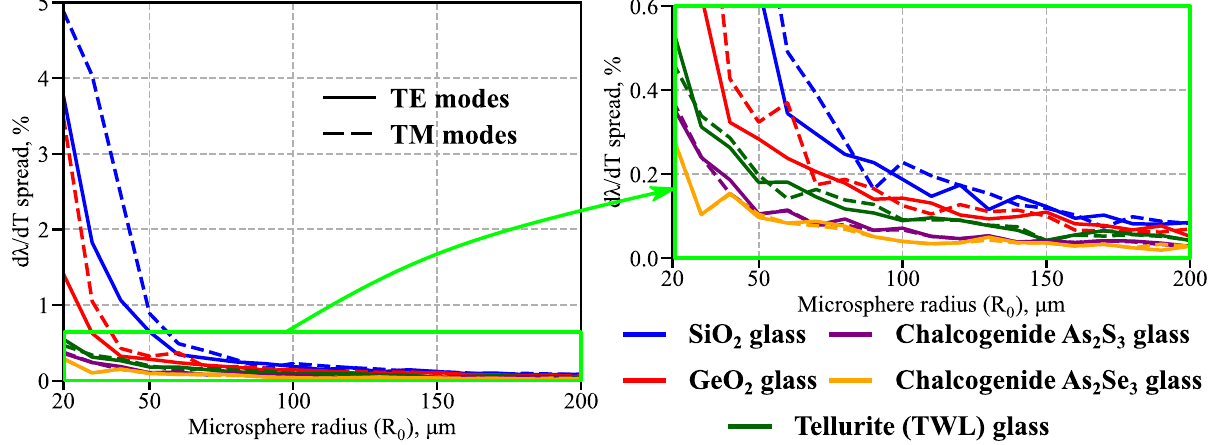
Figure 6. Calculated temperature sensitivity spread (maximum relative variation in d λ /dT ) across WGMs with radial indices 1 ≤ q ≤ 10 as a function of microsphere radius R 0 for TE (solid lines) and TM (dashed lines) polarizations. Results are shown for T = T 0 = 293 K, λ = 1.55 μ m.